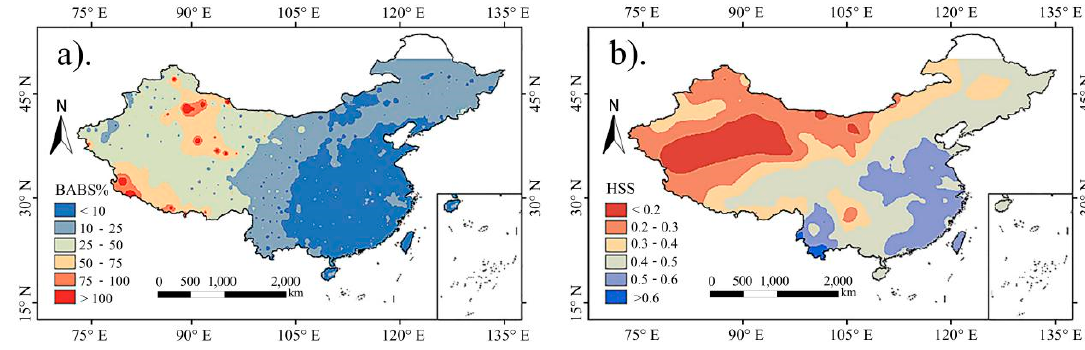
Figure 8. Spatial distribution of the BABS ( a ) and HSS ( b ) of the 3B42V7 data in mainland China.